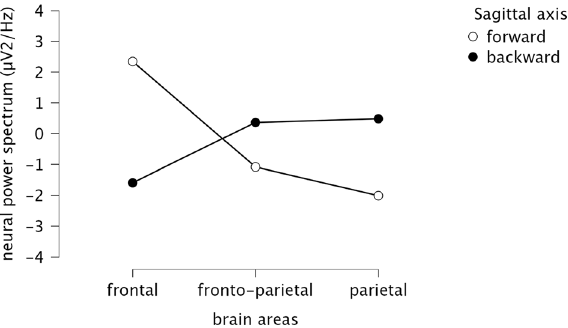
Figure 5. Comparison between forward and backward motor imagery (i.e. sagittal axis) in relationship with the average power spectrum in the three beta-frequency ROIs. X axis represents the selected ROIs (i.e. frontal, fronto-parietal and parietal); Y axis illustrates the average neural power spectrum (μV 2 /Hz) in beta-frequency (13.5–30 Hz), i.e. power spectrum of the neural